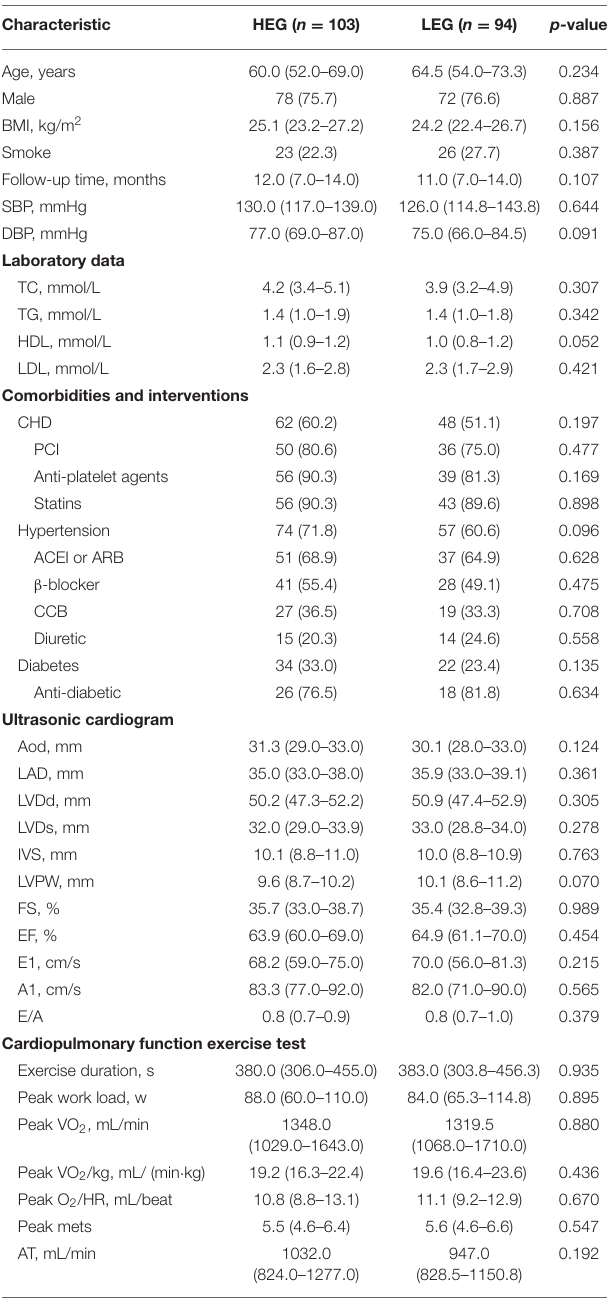
TABLE 1 | Baseline characteristics of